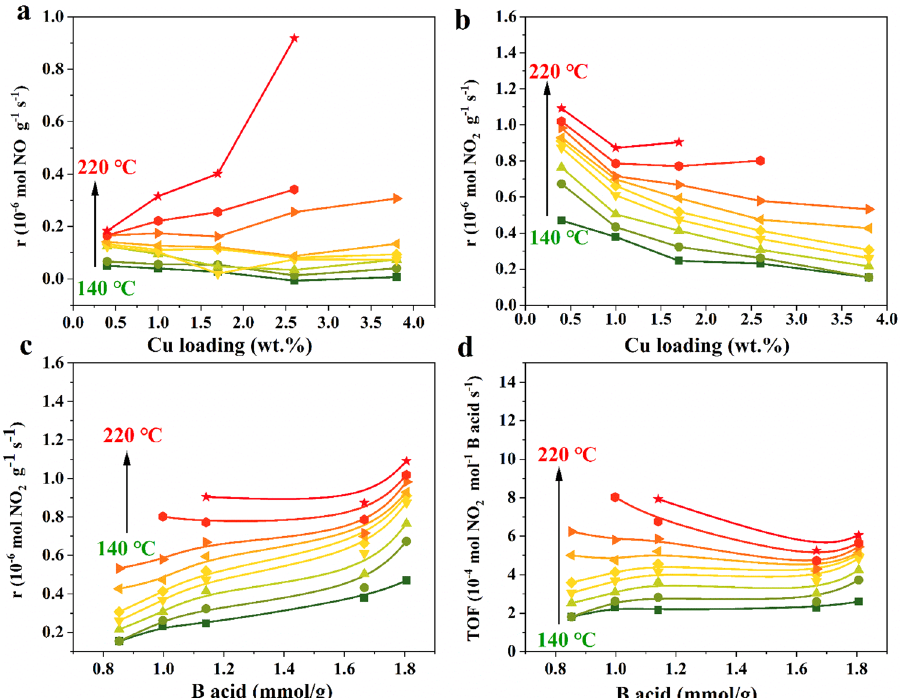
Fig. 2 | Kinetic analysis of fast SCR reaction. a NO reaction rates as a function of Cu loading over Cu-SSZ-13 catalysts in NO and NO 2 gas mixtures. b NO 2 reaction ratesasafunctionofCuloadingoverCu-SSZ-13inNOandNO 2 gasmixtures. c NO 2